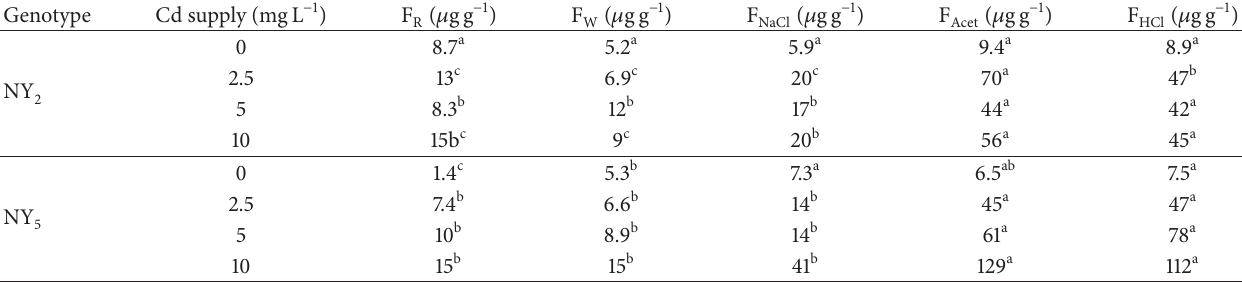
Table 5: Cd chemical forms of leaves in two Jerusalem artichoke genotypes.